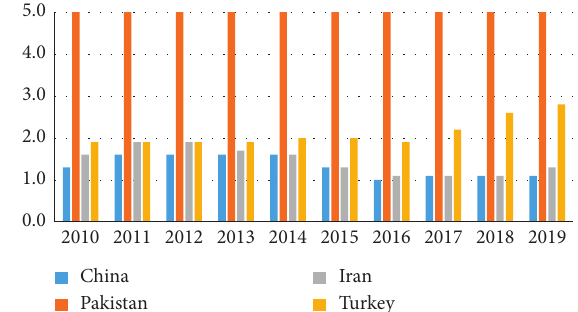
Figure 6: Internal conflicts fought of four countries from 2010 to 2019. Source: https://www.visionofhumanity.org/maps/#/ (global peace